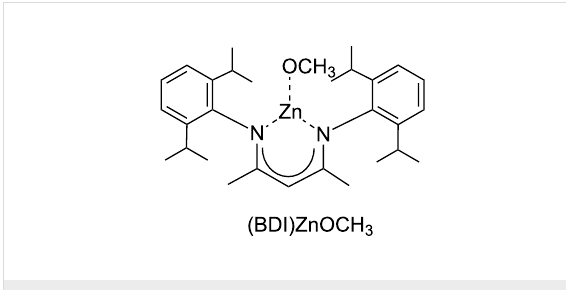
Figure 1: The tri-coordinated di-iminate zinc–alkoxide complex [(BDI)ZnOCH 3 ].